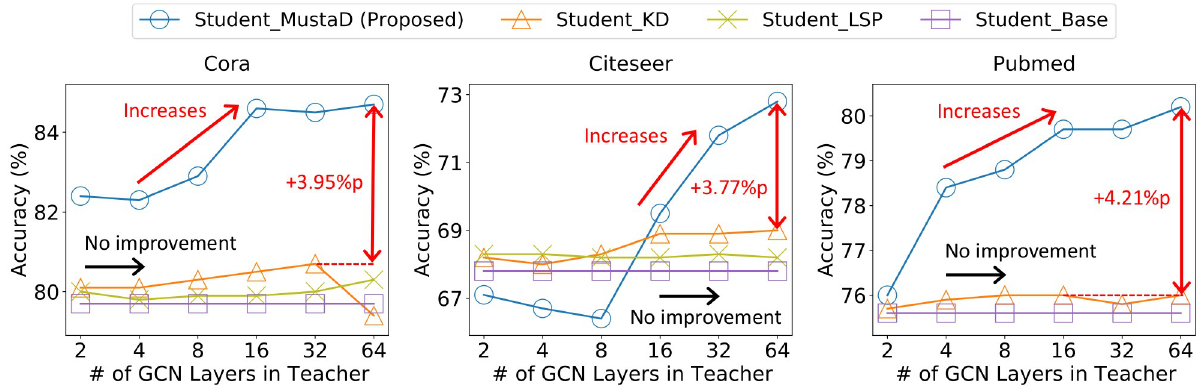
Fig 2. Accuracy of student models for different number of GCN layers in a teacher model. Student_KD and Student_LSP represent the students trained by distilling the knowledge of classes, and knowledge of the embedded topological structure of a teacher, respectively. Student_Base corresponds to a model trained with the ground truth labels without the teacher. Note that our proposed M USTA D (denoted as Student_M USTA D) provides the highest accuracy in most cases. We also observe that M USTA D provides much better performance for deep GCN with many layers, unlike competitors whose performances do not improve with more